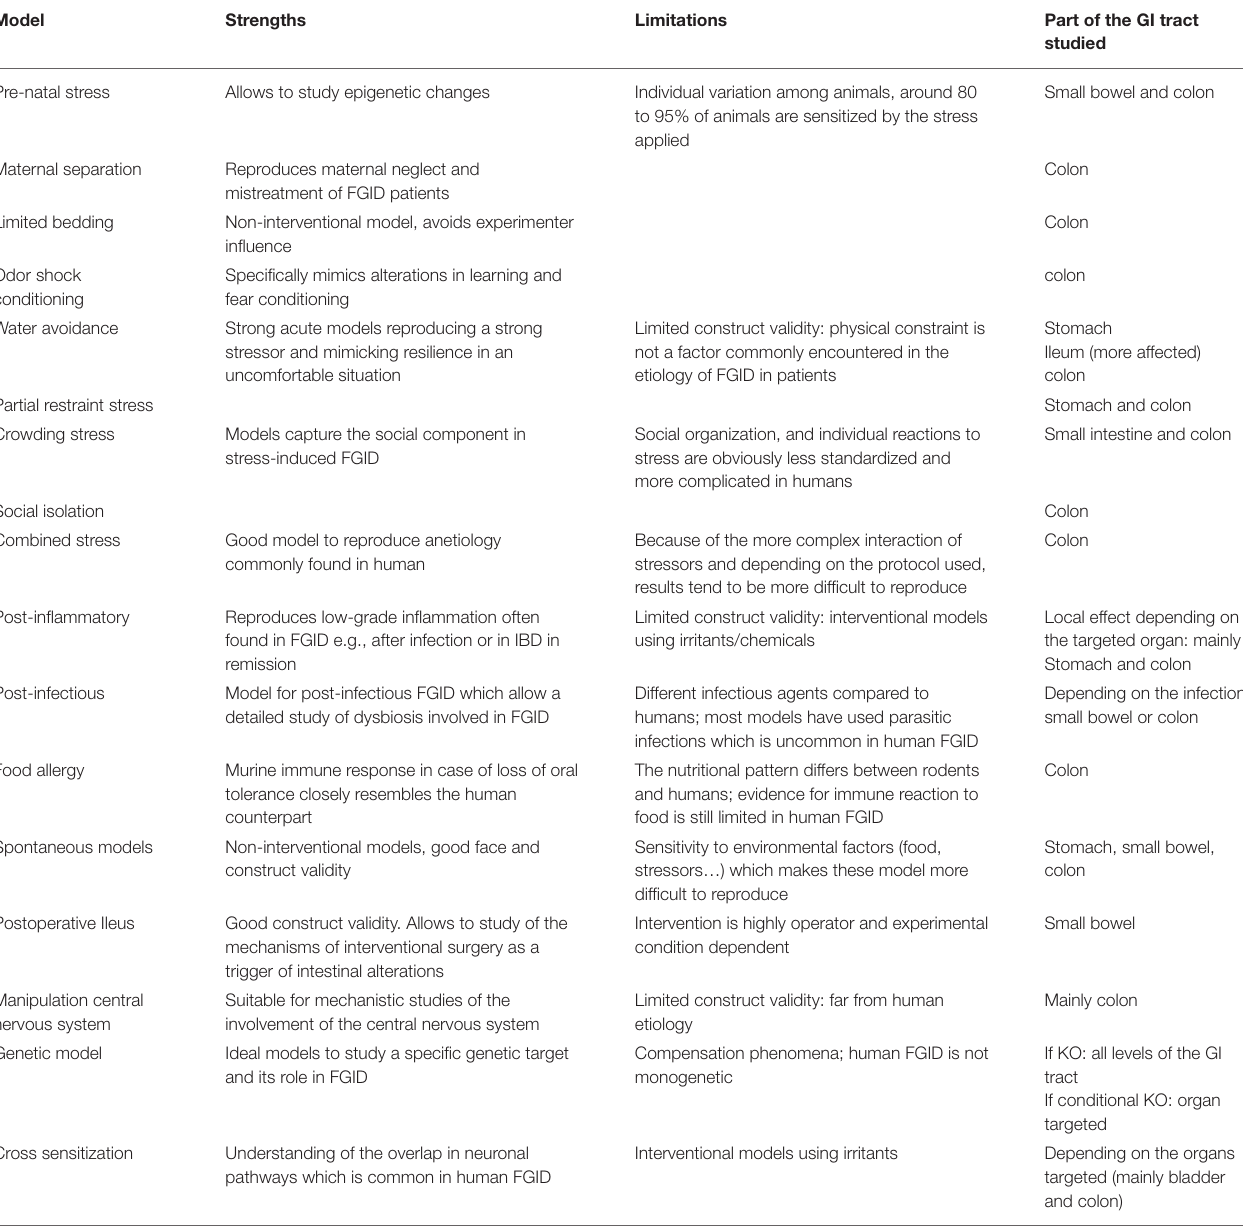
TABLE 2 | Strengths and limitations for common models of Functional GI